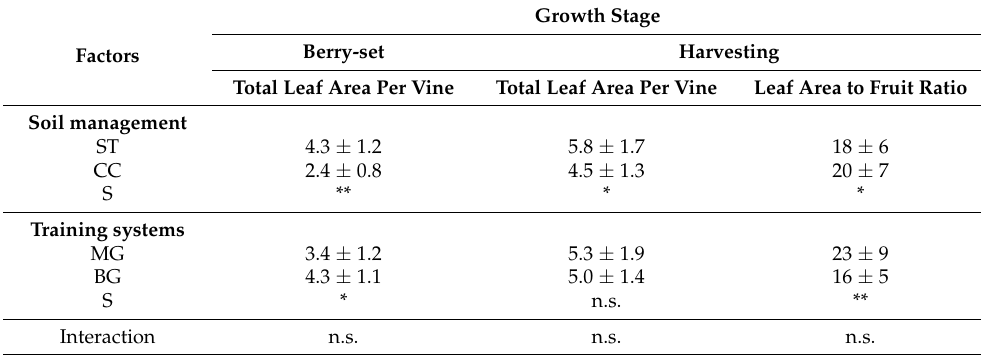
Table 2. Vine total leaf area (m 2 ) at berry-set and harvesting stage in the soil management and training system with calculated leaf area to fruit ratio (cm 2 /g) at